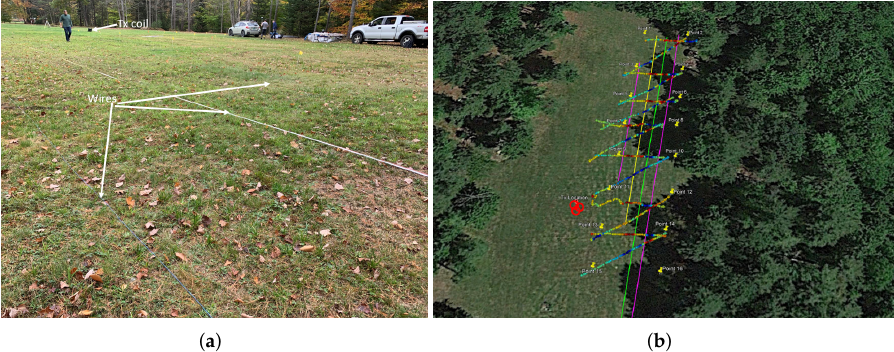
Figure 14. Wet grassy environment testing. ( a ) Location of targets and TX. ( b ) Detection map—purple, yellow, and green lines show the approximate layout of the targets. Heat map response shows survey lines, where red correlates to a large increase in